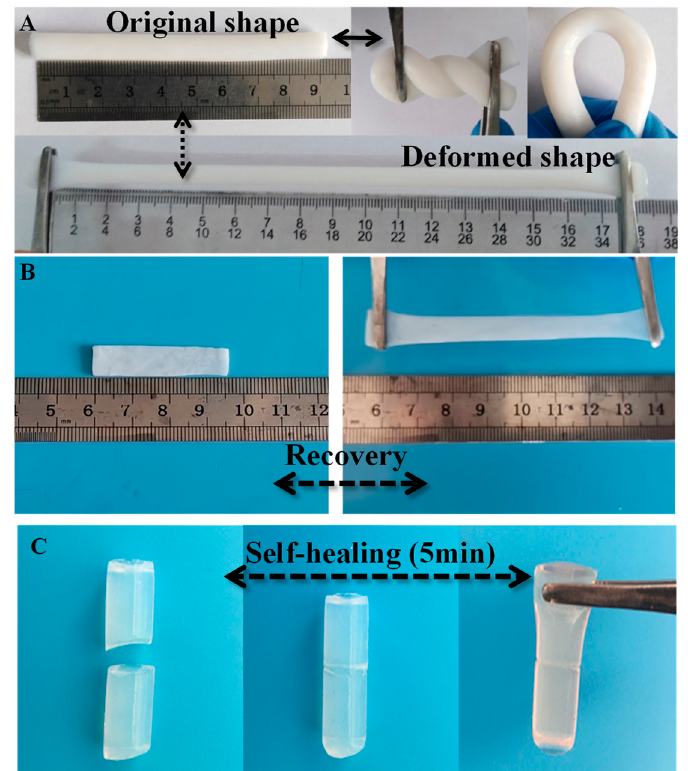
Figure 8. The digital photography of the elastic deformation, recovery ( A , B ) and the self-healing ( C ) of IL/PVA/H 2 SO 4 polymer gel.